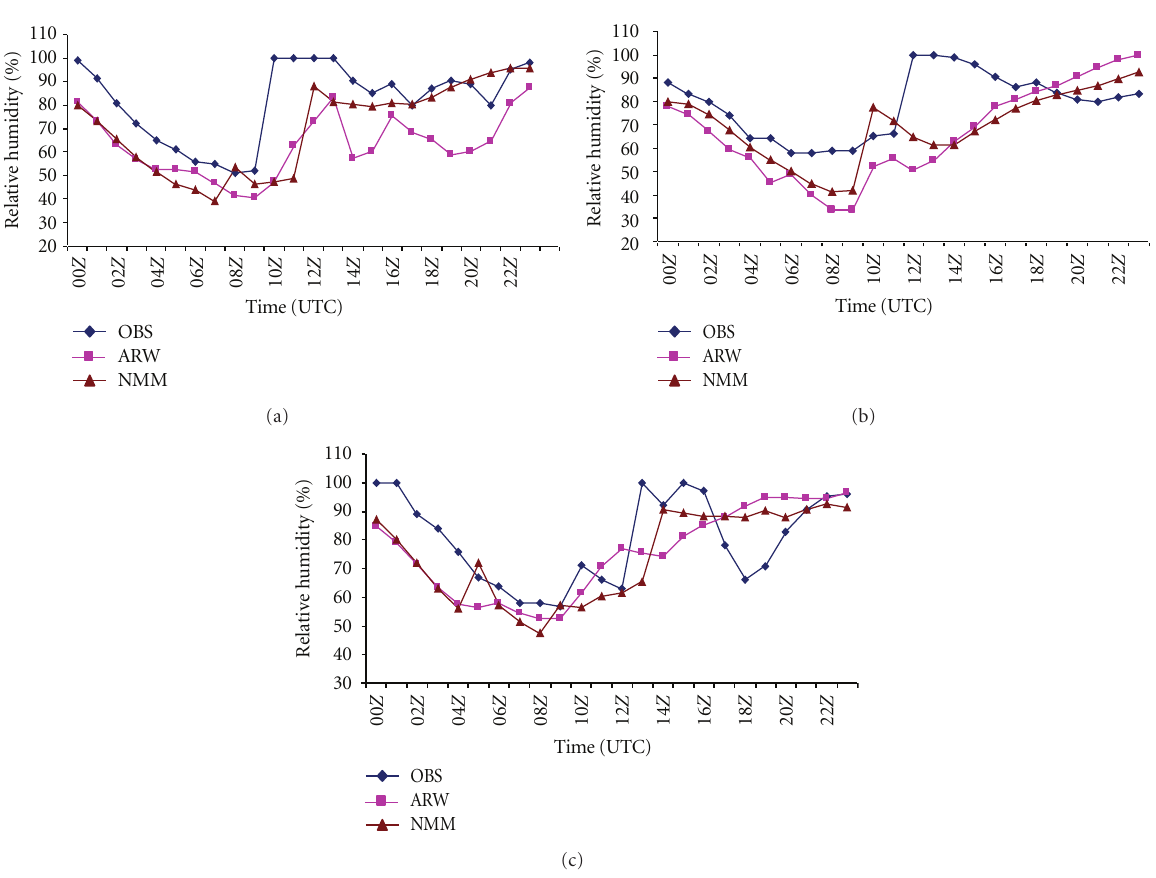
Figure 2: Inter comparison of NMM and ARW model simulated and observed diurnal variation of surface relative humidity (%) over Kolkata on (a) 03 May 2009 (b) 11 May 2011 (c) 15 May